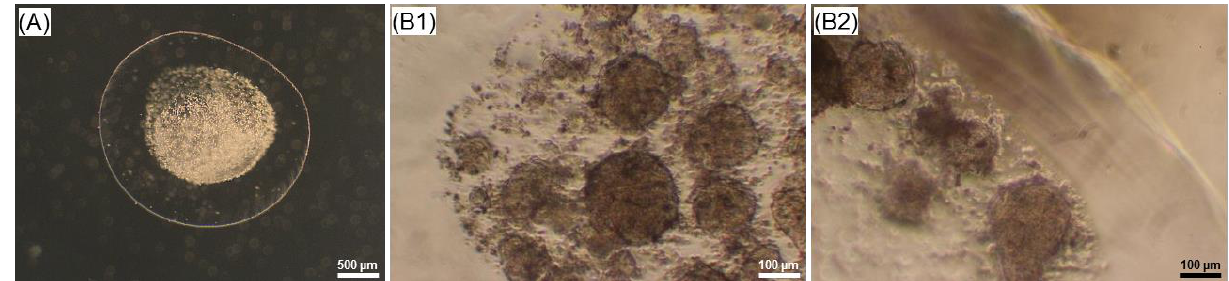
Figure 10. Bright-field images of hESCs within core-shell capsules directly after encapsulation ( A ) and after 4 days of cultivation in StemMACS iPS-Brew XF ( B1 , B2 ). The cells were encapsulated at a concentration of 5 × 10 6 cells/mL. Scale bars are 500 µm ( A ) and 100 µm ( B ).